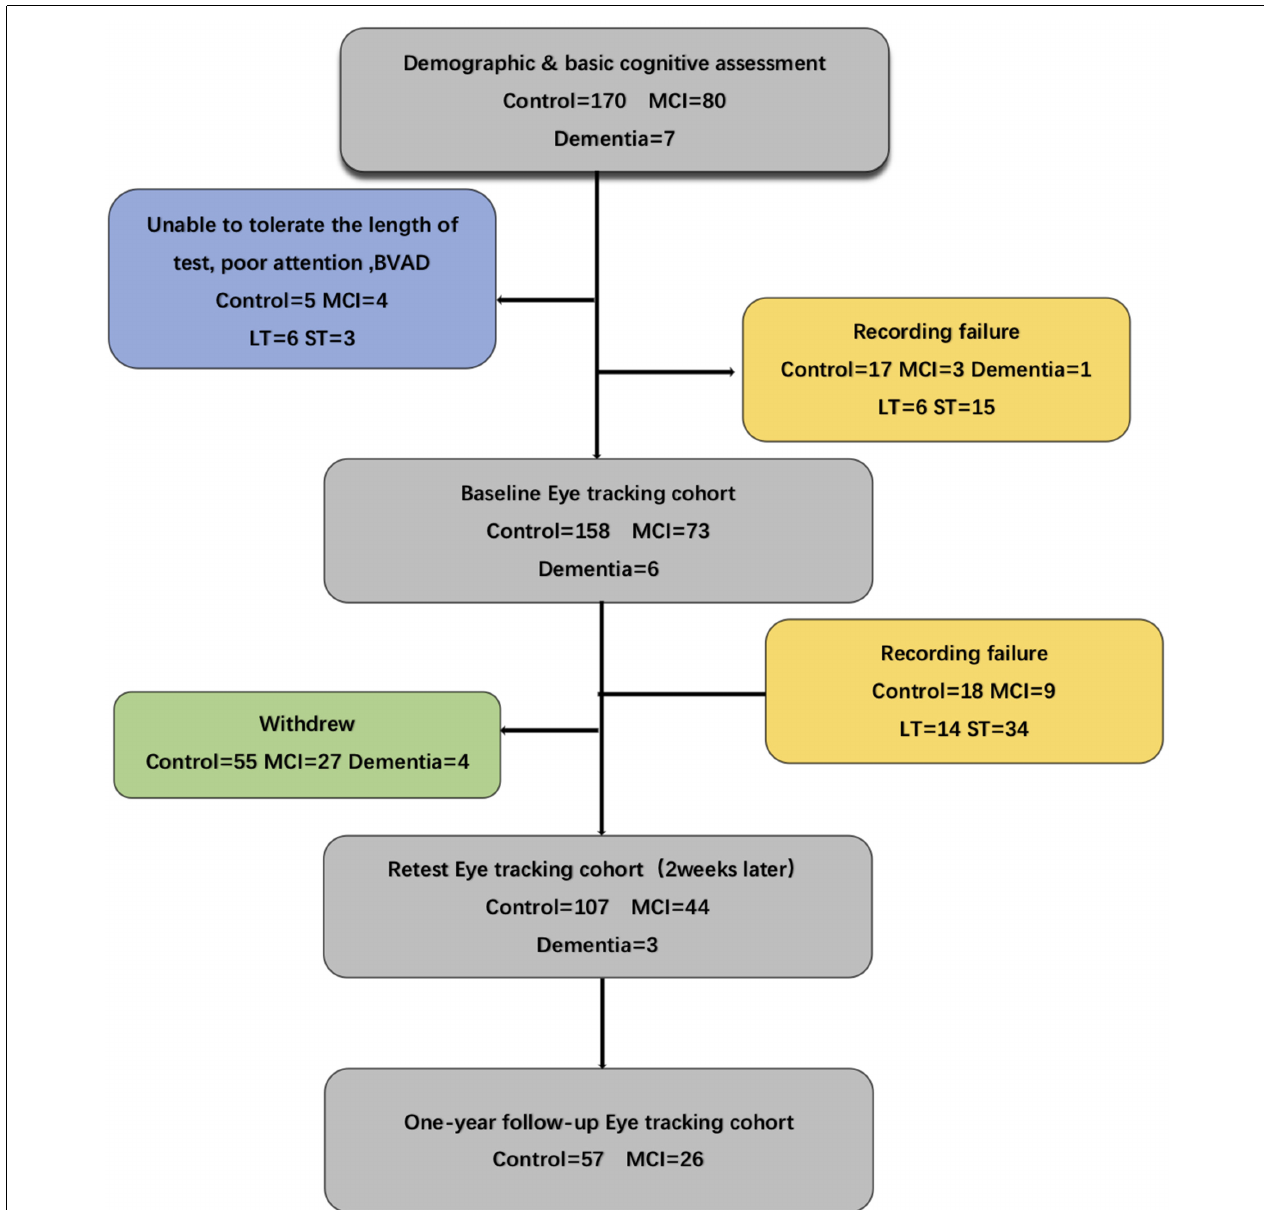
FIGURE 1 | Flow chart for the eye-tracking study indicating recording failure or problems with tolerance to the procedure. Several of the eye-tracking cohorts failed to complete the whole test. MCI, mild cognitive impairment; BVAD, binocular visual acuity differences; LT, long task: eye moving type sets of 30 min; ST, short task: eye moving type sets of 5